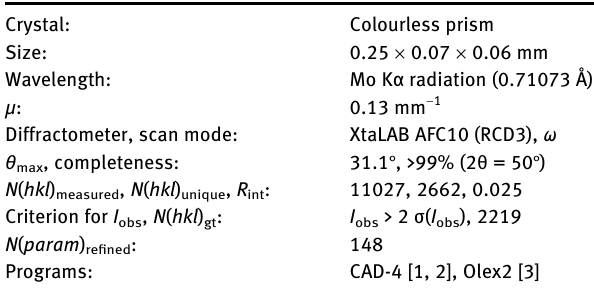
Table  : Data collection and